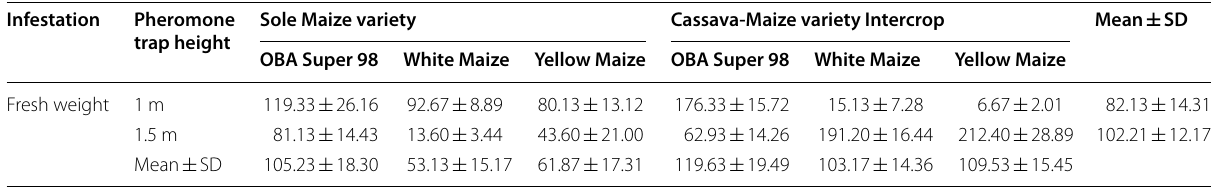
Table 3 The mean SD effect of cropping pattern and maize variety on the fresh weight of maize cob cultivated ± in the Niger Delta Region of Nigeria under two pheromone heights as a means of determining FAW population dynamics